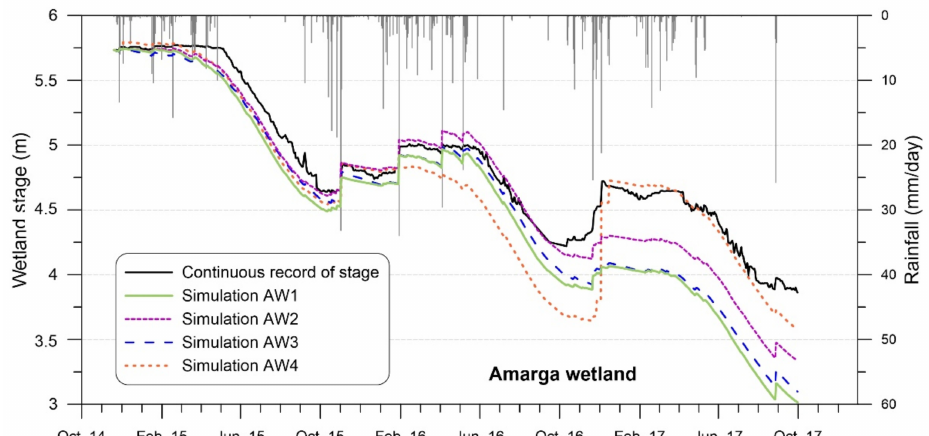
Figure 7. The best four limnimetric simulations of the Amarga wetland (October 2014–September 2017) and the daily wetland stage and rainfall records. AW1, CN runoff with an I a of 15 mm and Penman evaporation; AW2, CN runoff with an I a of 15 mm and Penman–Monteith evaporation; AW3, CN runoff with an I a of 15 mm and Penman evaporation corrected by Vardavas and Fountoulakis; J4, SWB runoff with Blaney–Criddle ETP, AWC of 50 mm, 75% RC, and Penman evaporation corrected by Vardavas and Fountoulakis.